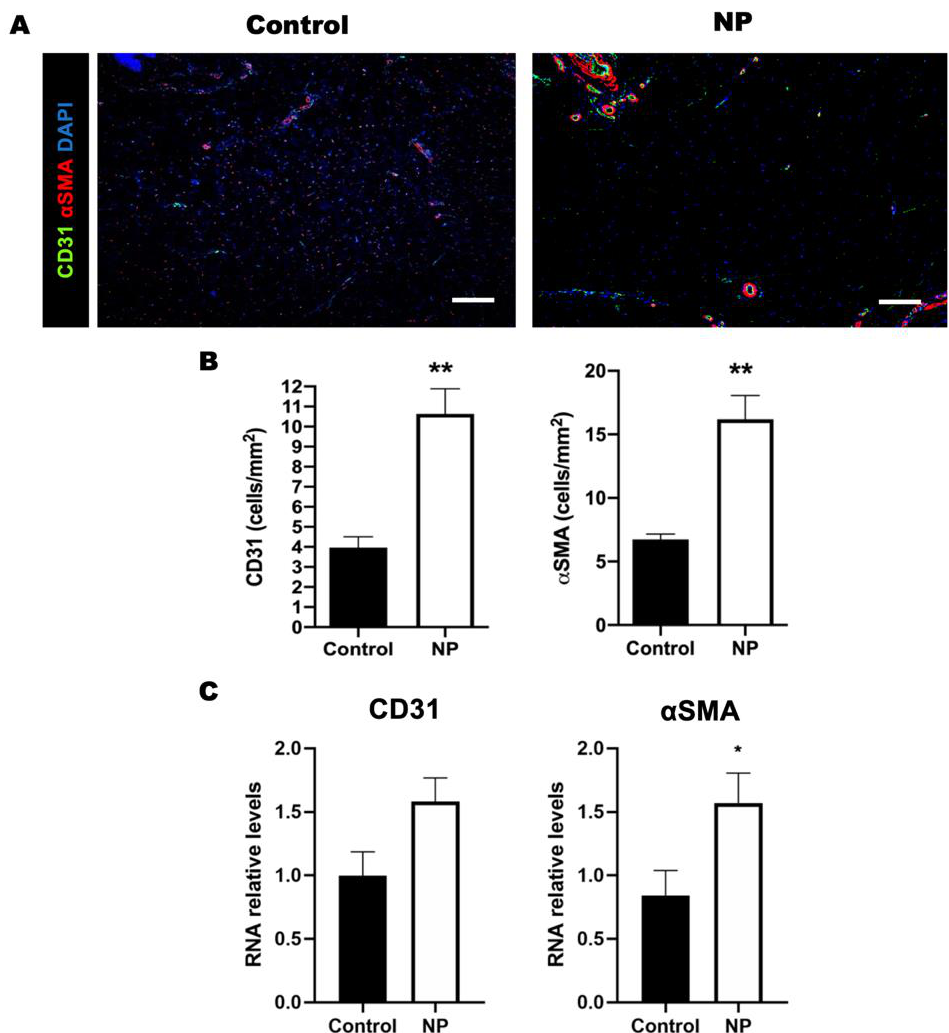
Figure 5. The level of angiogenesis in the wound area is elevated after negative-pressure treatment. ( A ) Immunohistological staining of CD31 (green) and α SMA (red) in the control and NP groups. ( B ) The density of blood vessels labeled with CD31 and α SMA is higher in the NP group. ( C ) The RNA expression of CD31 and α SMA in the control and NP groups (n = 4). Scale bar: 200 µ m. * p < 0.05, ** p < 0.01. Error bar: standard error. 3.4. Negative Pressure Treatment Decreased the Inflammatory Response in the Animal Study Immunofluorescent staining of the specimens revealed the reduced infiltration of CD3 + ( p = 0.02), CD4 + ( p = 0.03), CD8 + ( p < 0.01), and CD45 + ( p = 0.04) cells in the NP-treatment group compared to the control group (Figure 6A,B). The infiltration of CD 68 + cells was similar between the two groups ( p = 0.25) (Figure 6). The RNA expression of another macrophage marker (CD14) (control vs. NP: 1.0 ± 0.18 vs. 1.2 ± 0.26, p = 0.58) also showed no significant increase in RNA expression. The expression of the proinflammatory cytokine tumor necrosis factor alpha (TNF α ) in the NP group did not differ significantly from that of the control group (control vs. NP: 1.0 ± 0.12 vs. 1.5 ± 0.4, p = 0.27) (Figure